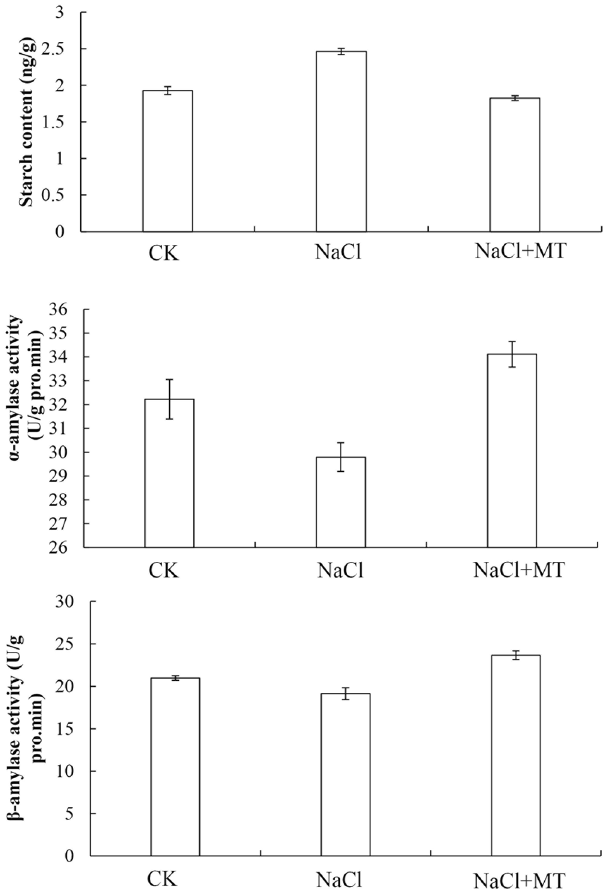
Figure 5. Effects of 1 μ M melatonin on starch content ( A ) and α , β -amylase activities ( B , C ) during germination of cucumber seeds under salt stress. Vertical bars represent ± S.E (n =